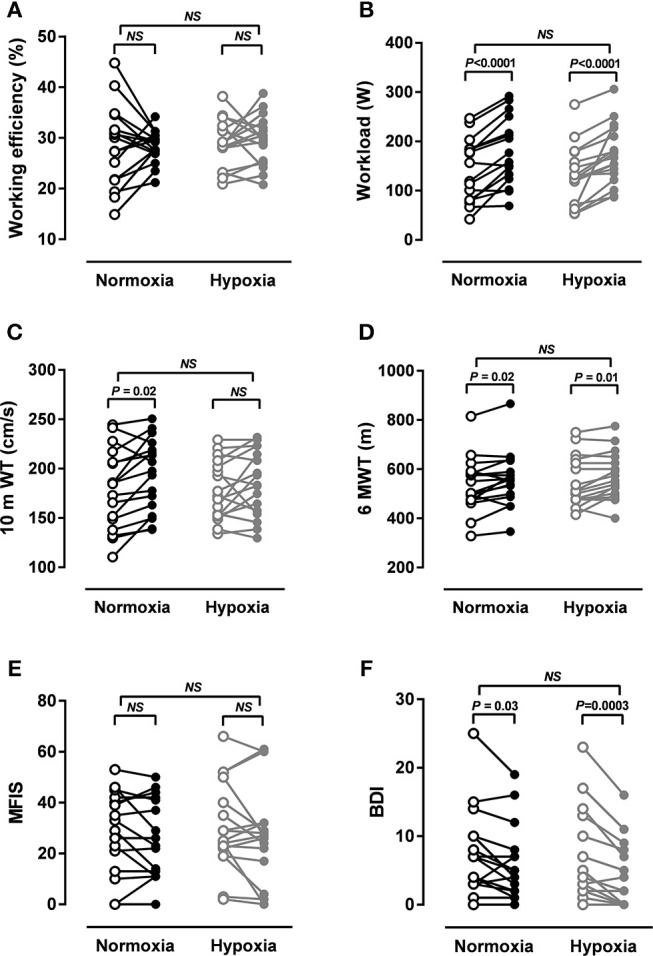
Fitness, walking ability, fatigue and depression. (A) Working efficiency, (B) maximal workload in an incremental treadmill test, (C) gait velocity in a 10 m walking test (10 mWT), (D) walking endurance in a 6 min walking test (6MWT), (E) Modified Fatigue Impact Scale (MFIS), (F) Beck Depression Inventory (BDI-I). All in MS patients after 4 weeks of normoxic (NO, n = 16, black circles) and hypoxic (HO, n = 17, gray circles) treadmill training. P-values by ANOVA and Sidak post-hoc test.